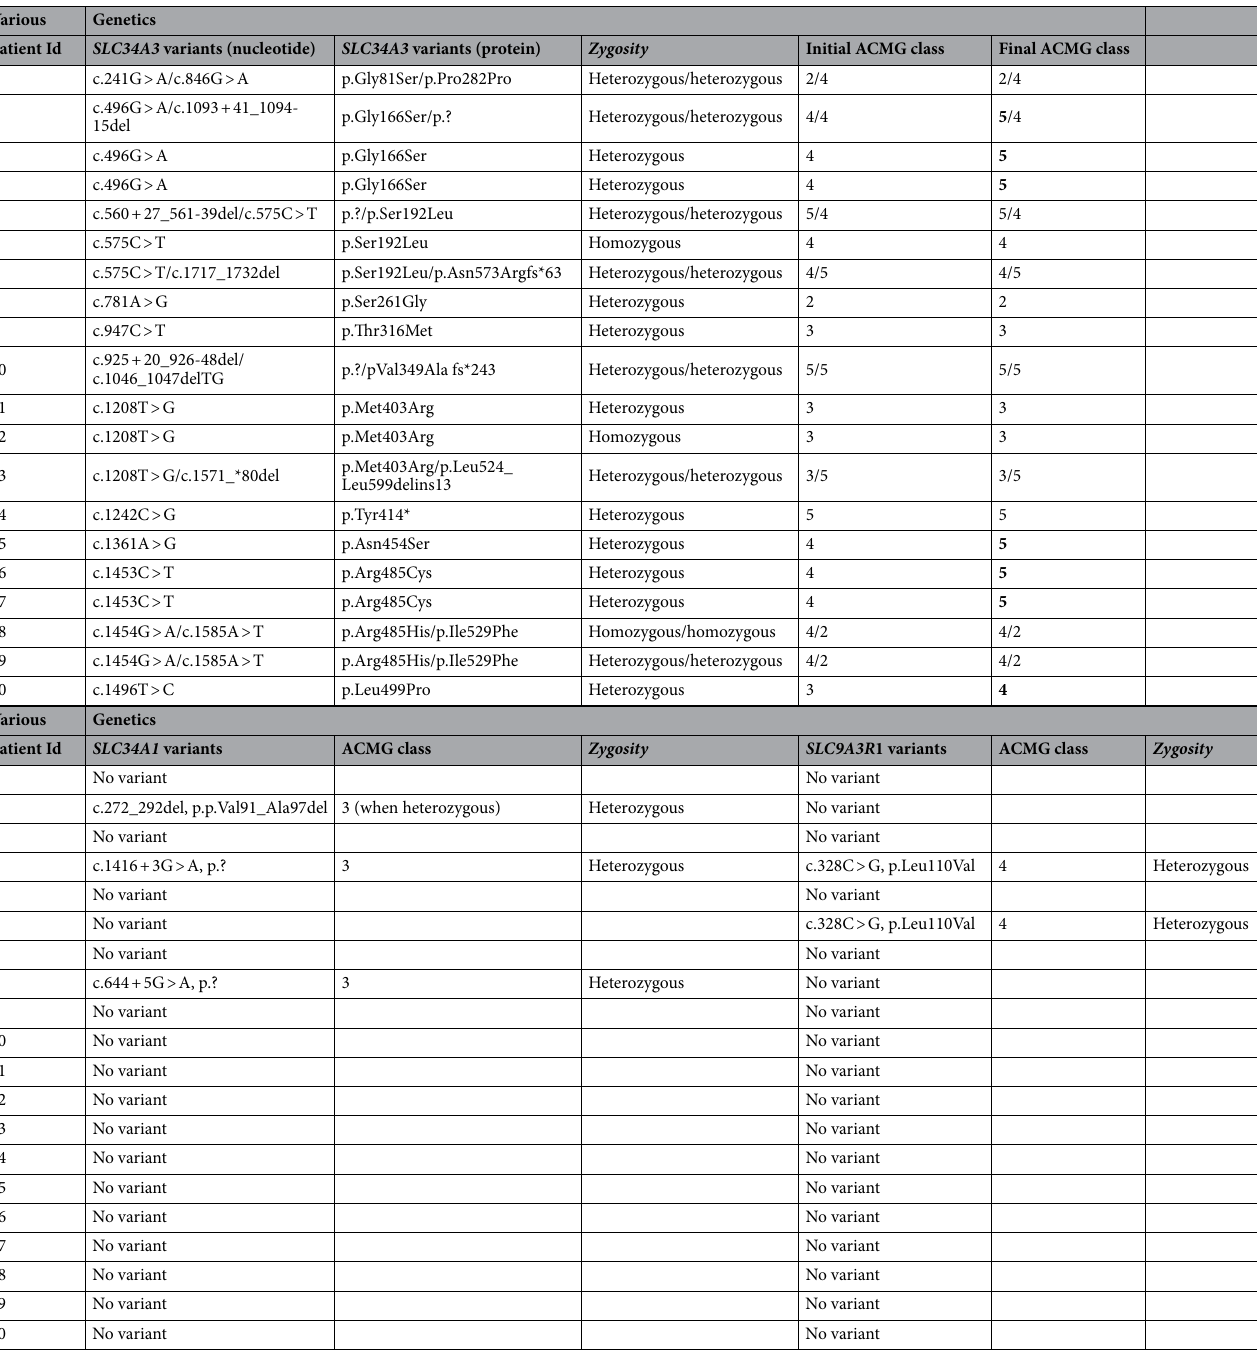
Table 2. Genotypic characteristics of patients with SLC34A3 variants. ACMG American College of Medical Genetics, SLC34A3 Solute Carrier Family 34 Member 3, SLC34A1 Solute Carrier Family 34 Member